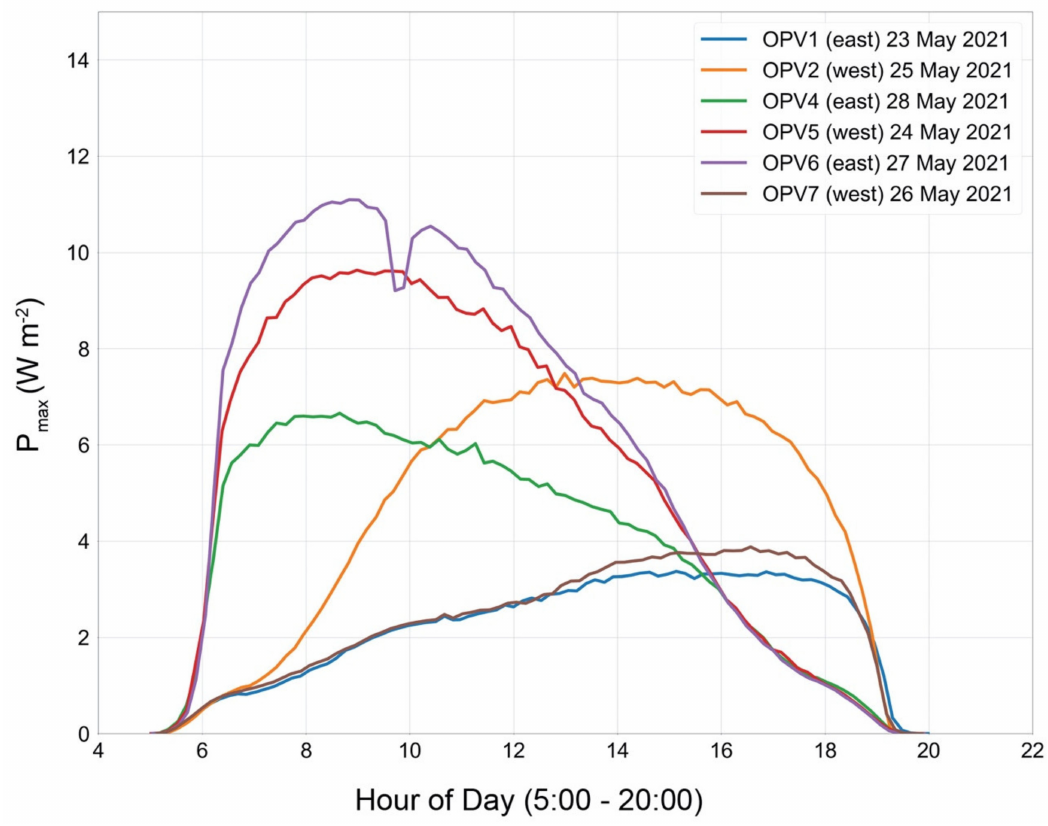
Figure 12. Diurnal power generation patterns (W m − 2 ) of the OPV arrays deployed on the greenhouse roof. The area beneath each curve represents the total daily energy output of each OPV array (in Wh m − 2